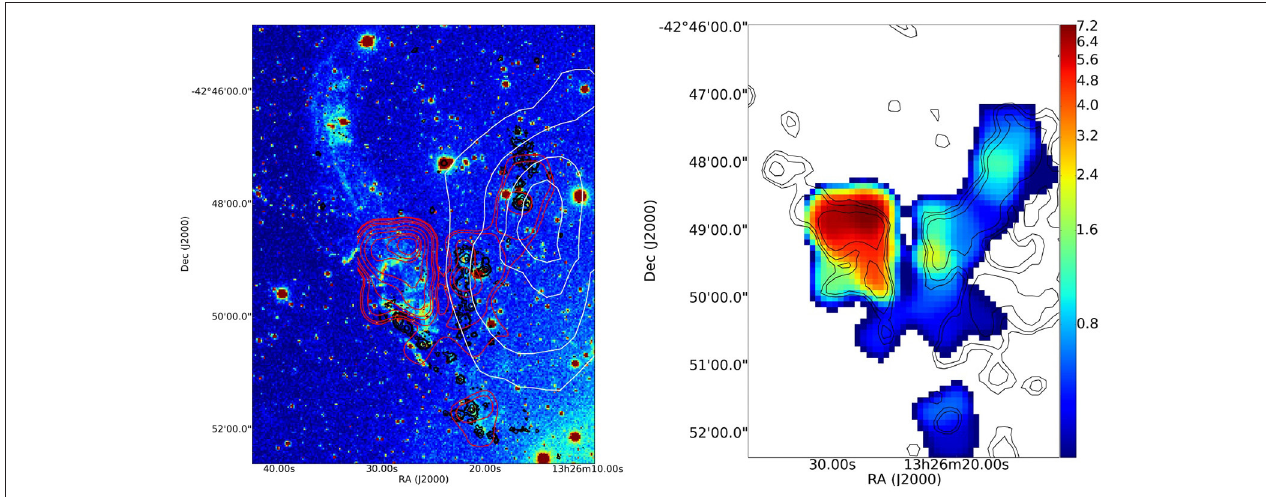
FIGURE 3 | Multi-phase filament in the radio jet of Centaurus A, from Salomé et al. (2016b), figure reproduced with permission. (Left) Superposed on the H α map, the red contours correspond to CO emission, the white to HI, and the black to FUV from GALEX. (Right) The black HI contours are superposed on the CO emission map, showing that most of the molecular gas is outside the HI